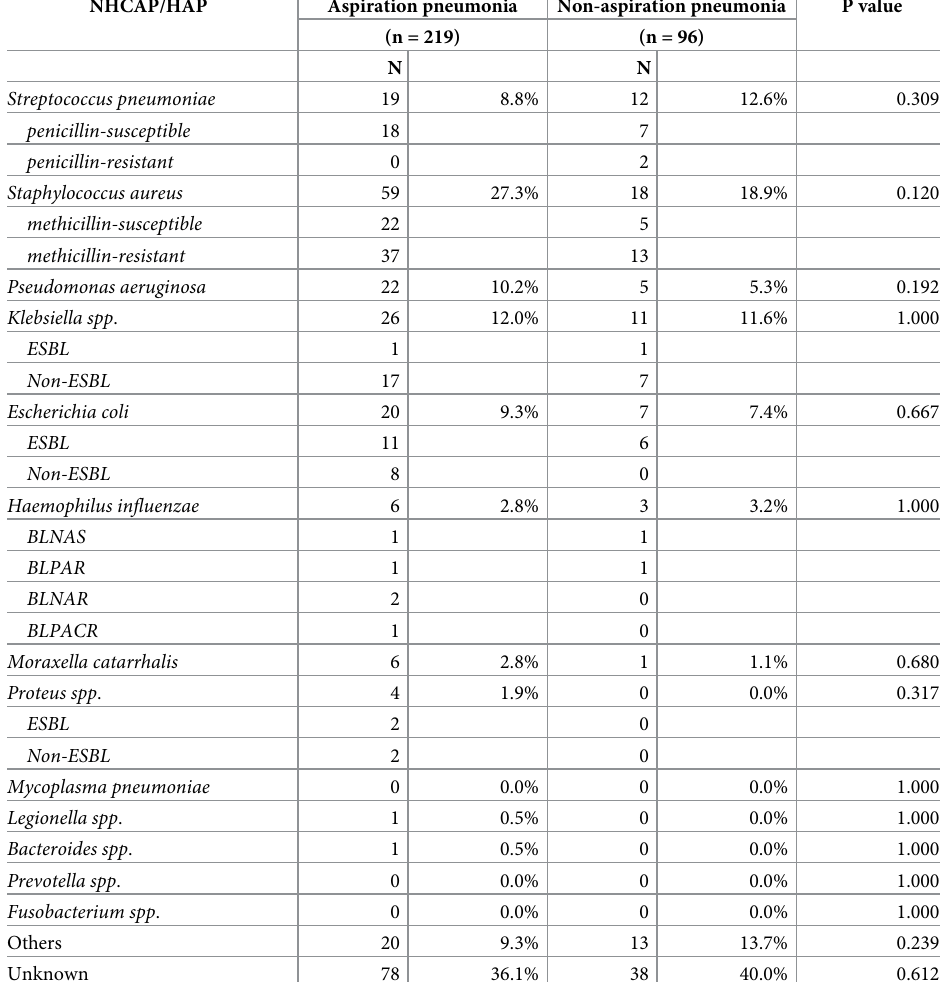
Table 7. Pathogen distribution in nursing- and healthcare-associated pneumonia and hospital-acquired pneumo- nia (NHCAP/HAP).